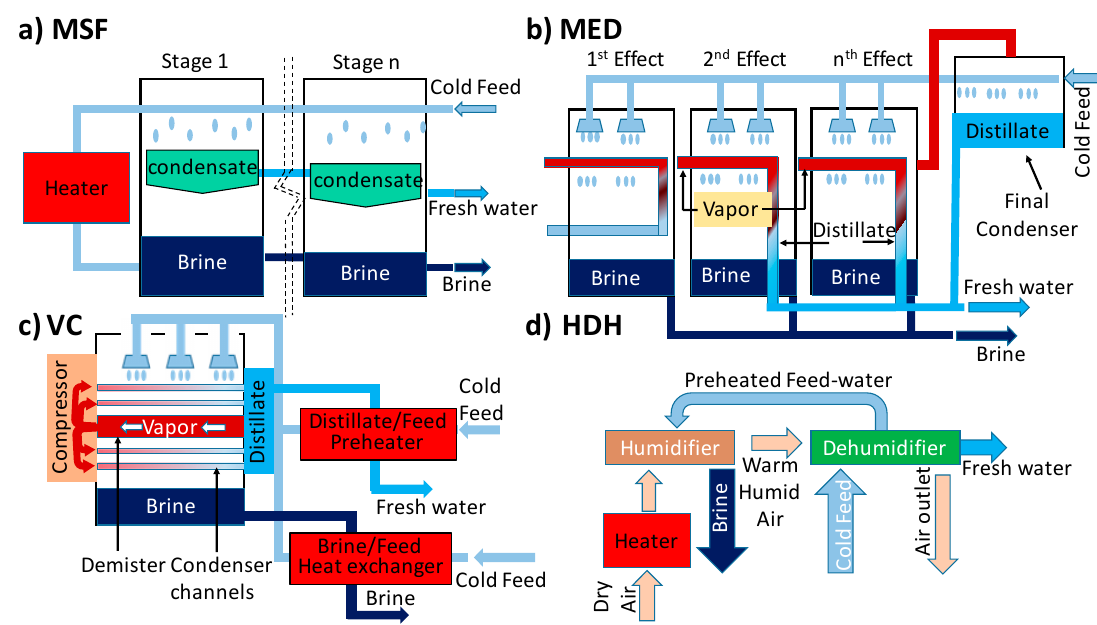
Figure 3. Typical scheme of thermal-based desalination modules; ( a ) multi-stage flash (MSF) distillation, ( b ) multi-effect distillation (MED), ( c ) vapor compression (VC), and ( d ) humidification– dehumidification (HDH).